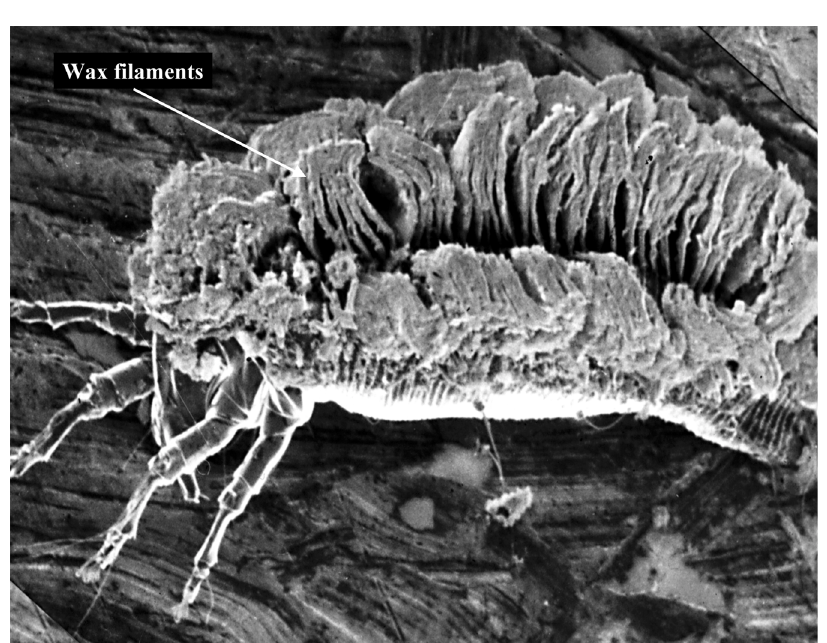
Fig. 11. A “fusiform” eriophy- id mite, Diptacus sacramentae (Keifer) (courtesy of De